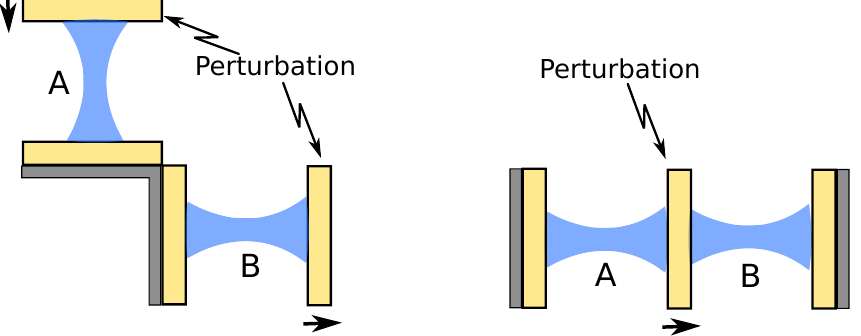
Figure 2. Left : two orthogonal cavities. Right : the related situation of a cavity with a mirror in the